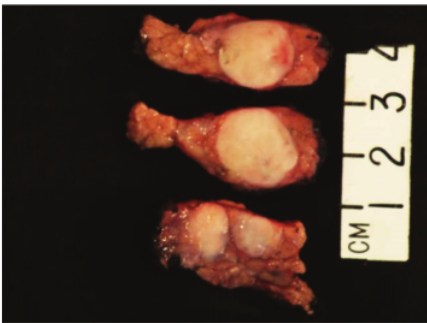
Figure 1: Gross photograph of circumscribed, firm nodules that are well demarcated from the surrounding unremarkable pancreatic parenchyma.